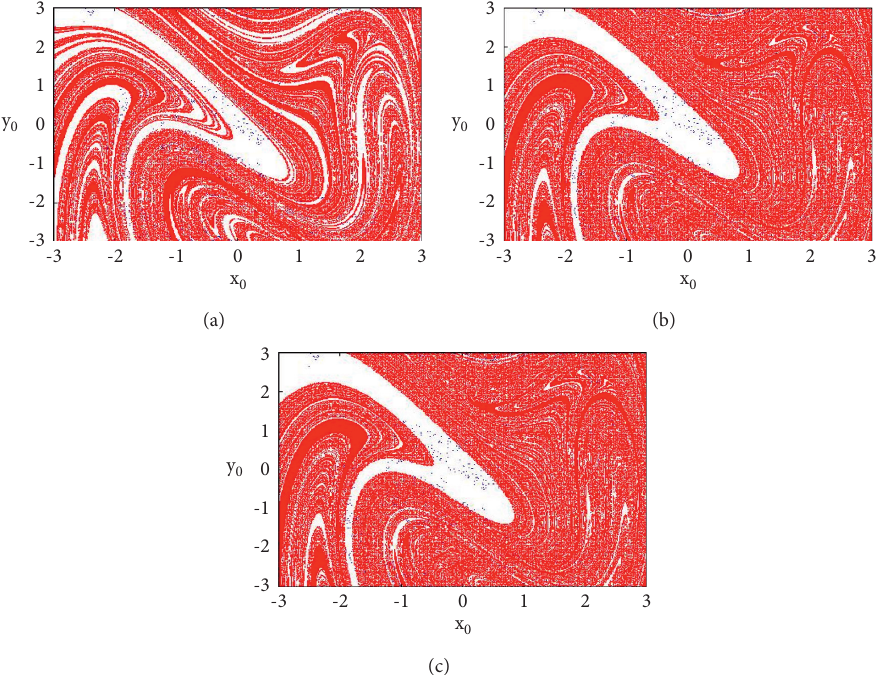
Figure 3: Melnikov threshold curves for homoclinic chaos in the ( f, Ω ) plane with ω � ( other parameters of Figure 1 are kept constant.